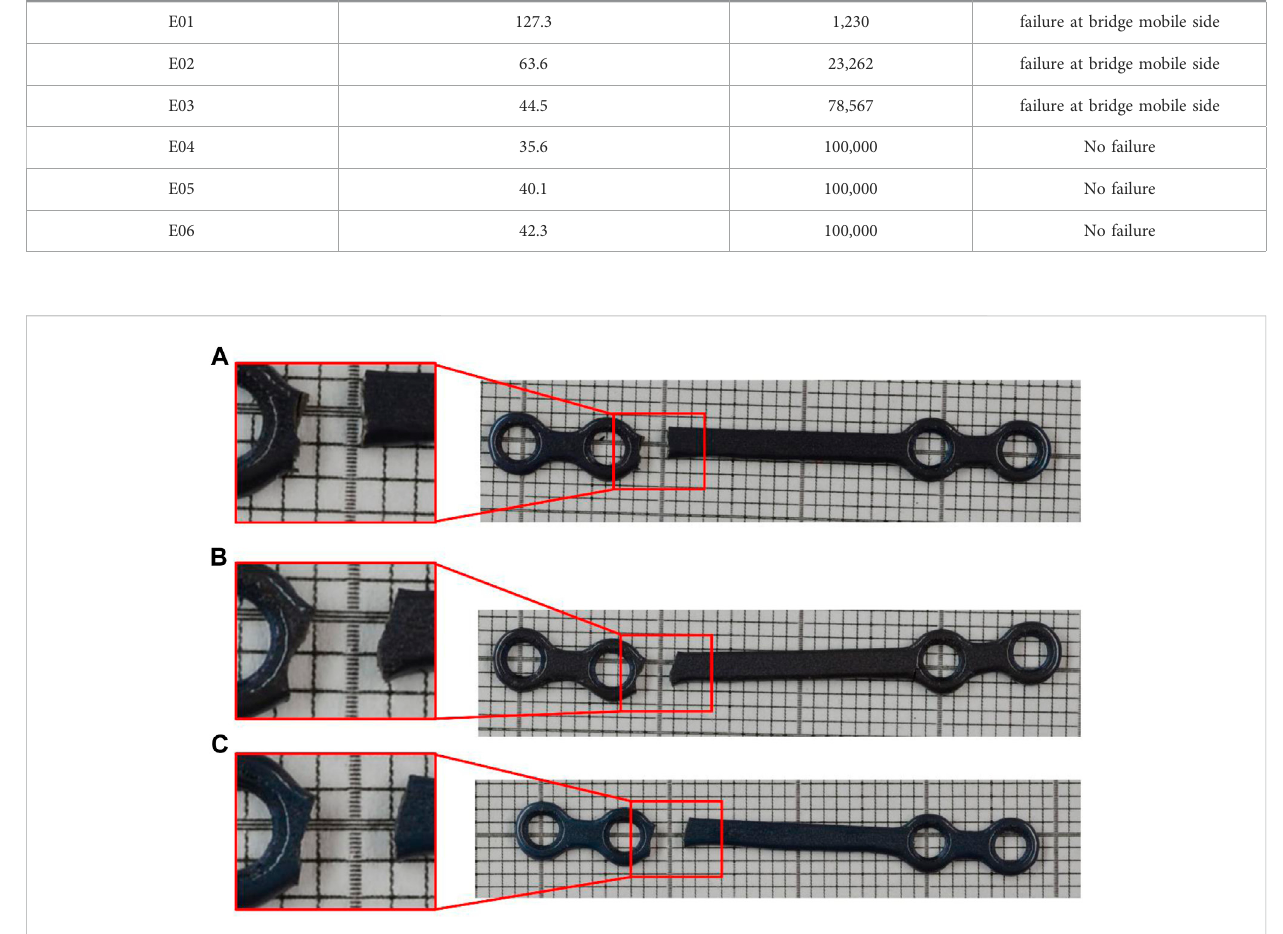
TABLE 2 Experimental number of cycles to failure ( N ) for the six samples tested at different force levels up to 100,000 cycles. Sample identi fi cation